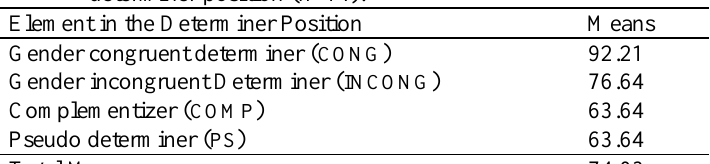
Table 3. Mean % correct responses as a function of the element in the determiner position